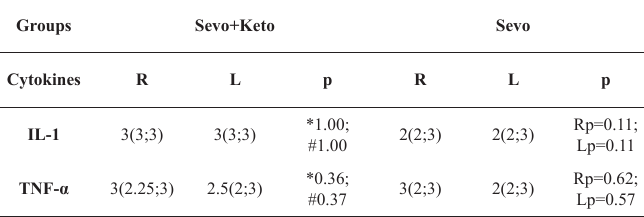
TABLE 2 – Scores of IL-1 and TNF-α (data reported as median, 25 th and 75 th percentile) in the right(R) and left